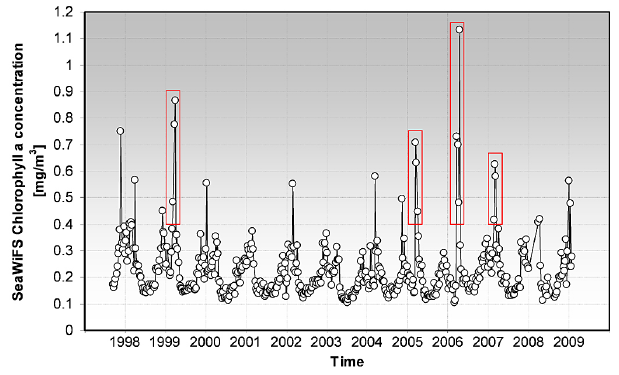
Fig. 4. SeaWiFS 8-day average Chlorophyll- a concentration time series for the area (41.5 ◦ N–42.0 ◦ N, 17.5 ◦ E–18.0 ◦ E) in the SA (data produced by NASA at http://reason.gsfc.nasa.gov/OPS/ Giovanni/ocean.swf8D.2.shtml#description). Red rectangles indi- cate periods with intense biomass